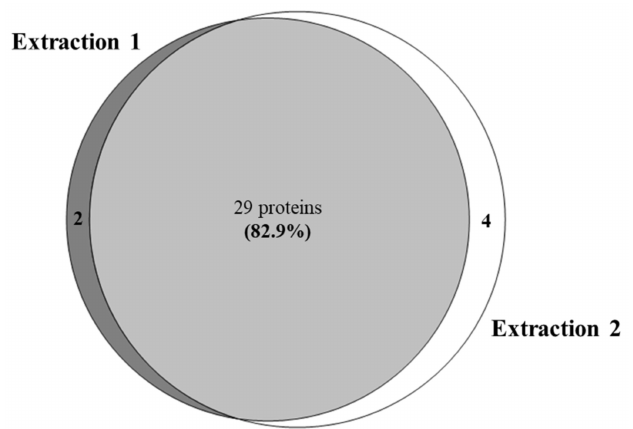
Figure 3. Venn diagram of the proteins identified by searching against the “The Comprehensive Antibiotic Resistance Database” CARD 15.